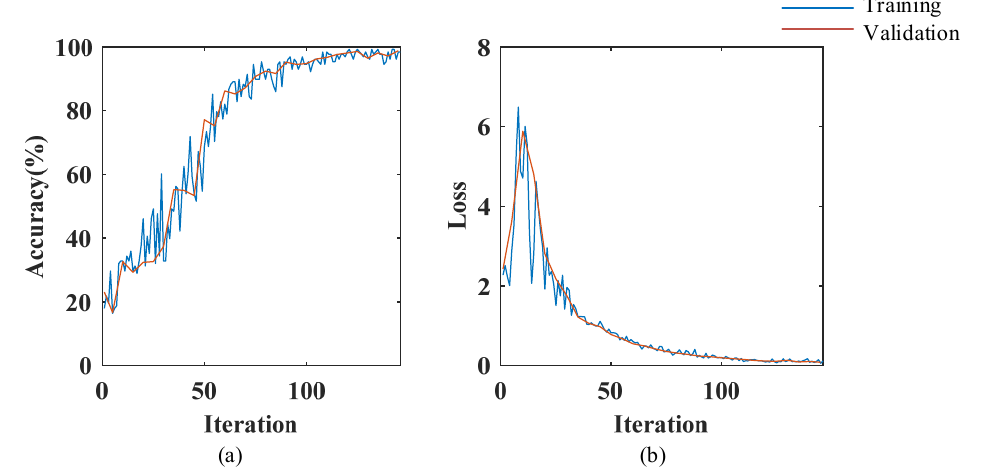
Figure 7. The CNN model training process. ( a ) Accuracy (%), ( b ) Loss. Table 6. The CNN identification results of the 1 # pipeline.